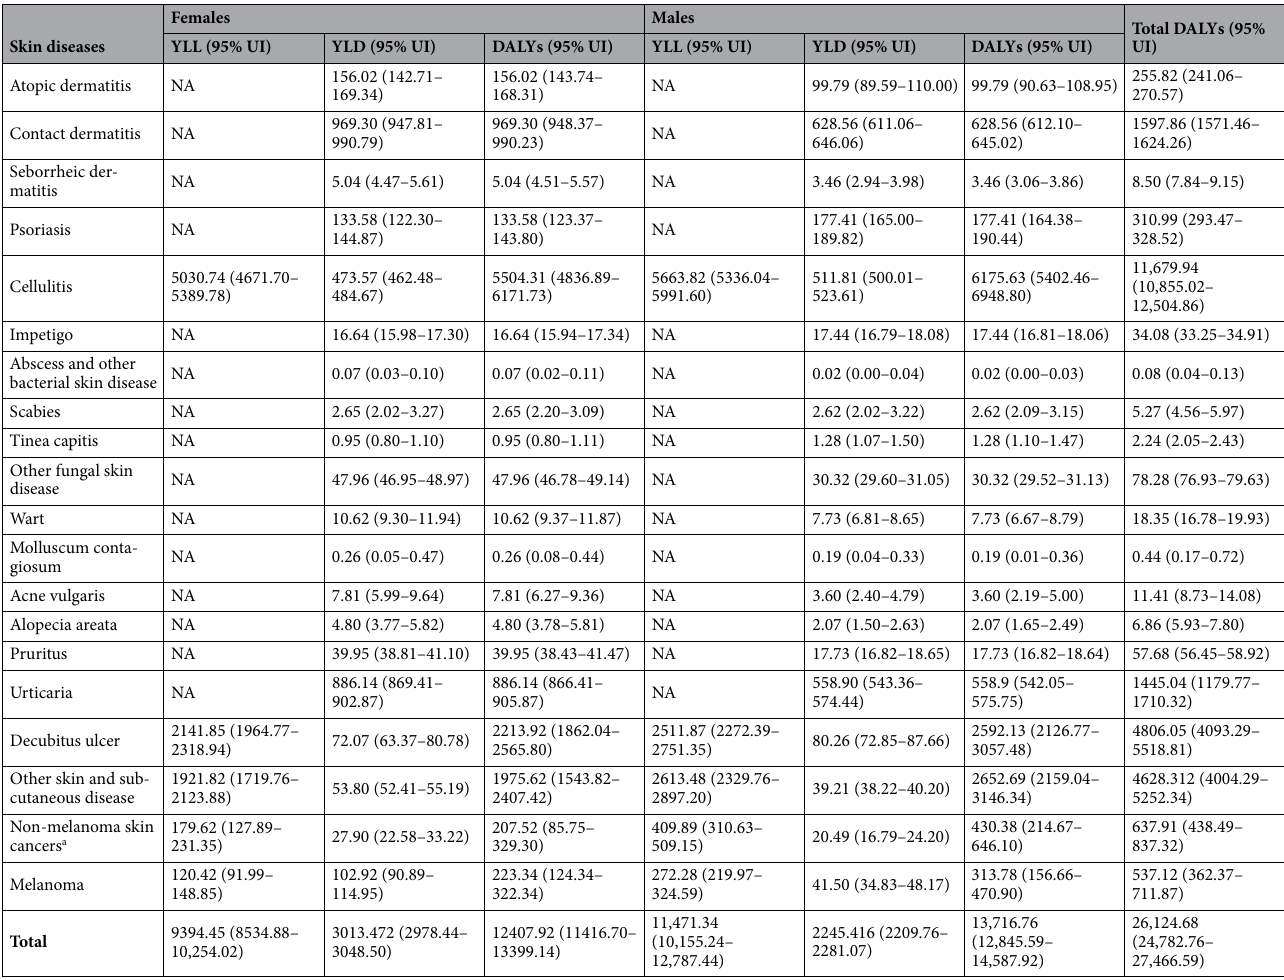
Table 2. YLL, YLD and DALYs of 21 skin diseases in Ubonratchathani, overall and by sex. 95% uncertainly intervals of YLDs, YLLs and DALYs computed using a parametric bootstrap technique. YLDs years lost due to disability, YLLs years of life lost, DALYs disability adjusted life years, NA not applicable. a Non-melanoma skin cancers included squamous cell carcinoma and basal cell